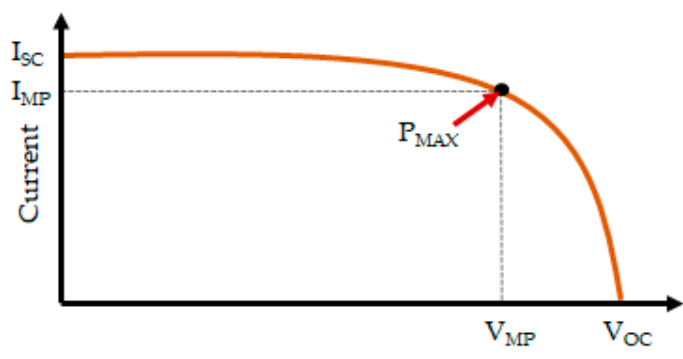
Figure 2. Diagram showing a typical current-voltage curve for a solar cell. The point where the maximum power is achieved has been annotated on the figure. This figure has been drawn and is not generated from collected data.